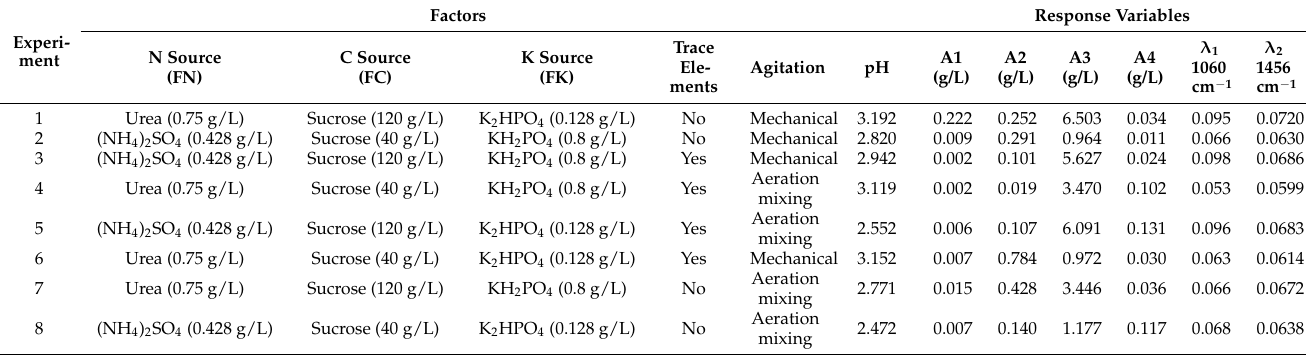
Table 2. Laboratory scale 2 5 − 2 fractional factorial design matrix with results. A1 (Oxalic acid), A2 (Citric acid), A3 (Malic acid), A4 (Acetic